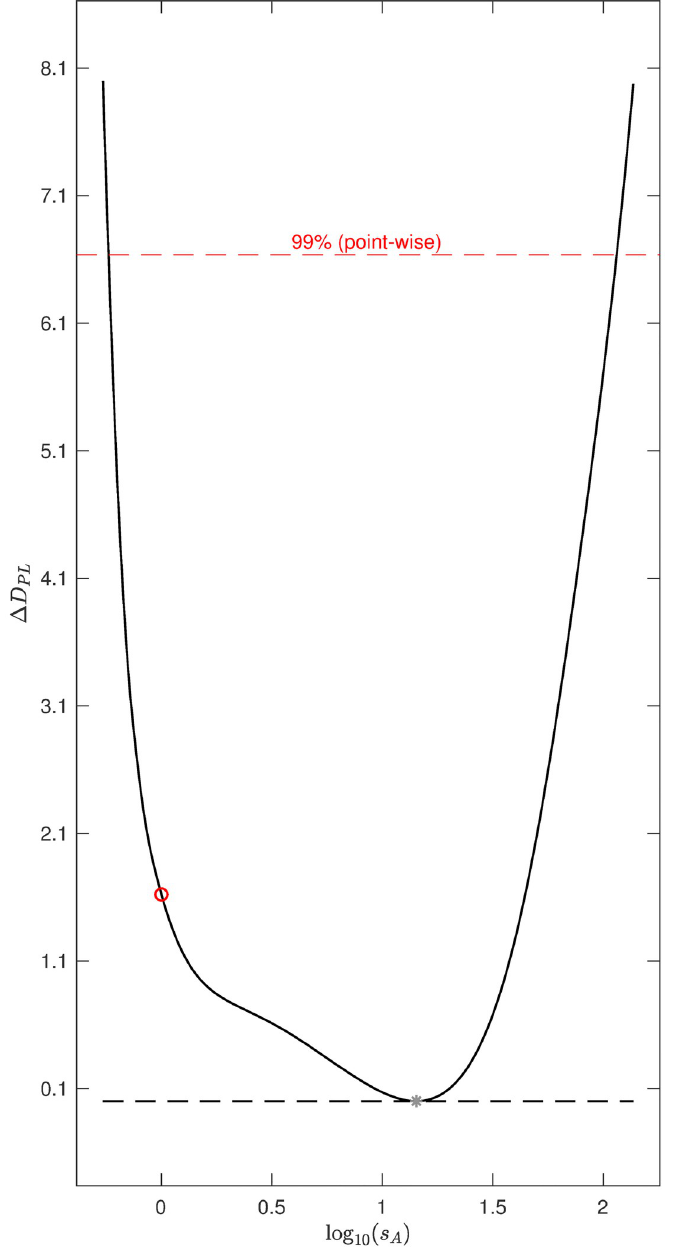
Fig 12. Profile likelihood plot for s A for the 20-edge 5 cytokine test model. The parameter θ m = s A 2 θ was varied over a broad range of values and for each fixed value of θ m , the increase in D computed, with L ð θ Þ the likelihood function as defined in Eq (3), and ~ θ confidence interval threshold is shown as a red dashed line and corresponds to a two order of magnitude interval for s A . The parameter value used to generate the synthetic dataset is shown as a red dot. The parameter value resulting in the minimal D ¼ min (cid:0) 2 log ð L ð θ ÞÞ is shown as a grey star. This figure has been generated using the Matlab θ environment ‘Data2Dynamics’ [32,